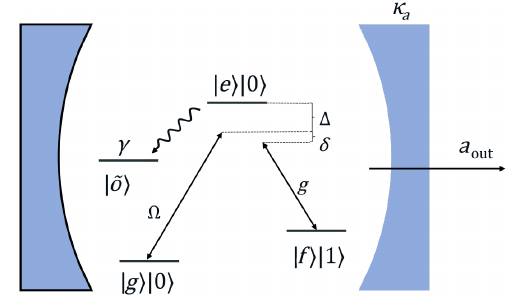
FIG. 5. The level structure of the photonic qudit